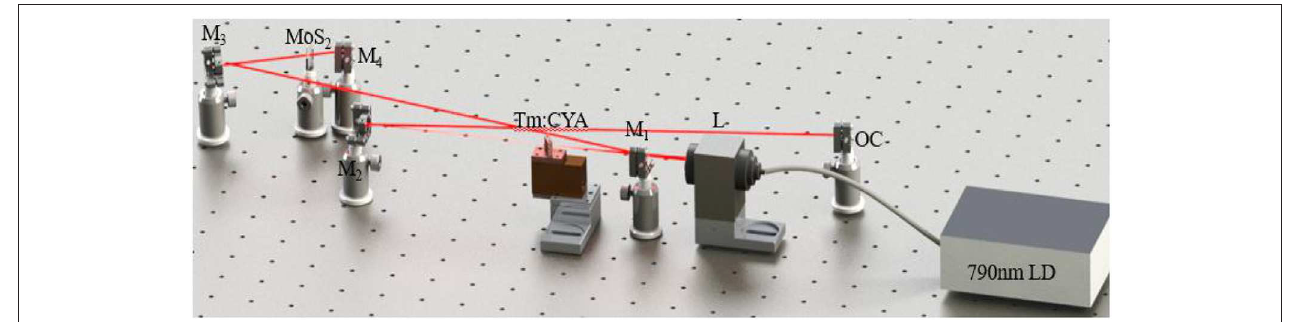
FIGURE 2 | The experiment setup of dual-wavelength Q-switched mode-locked Tm:CYA laser.